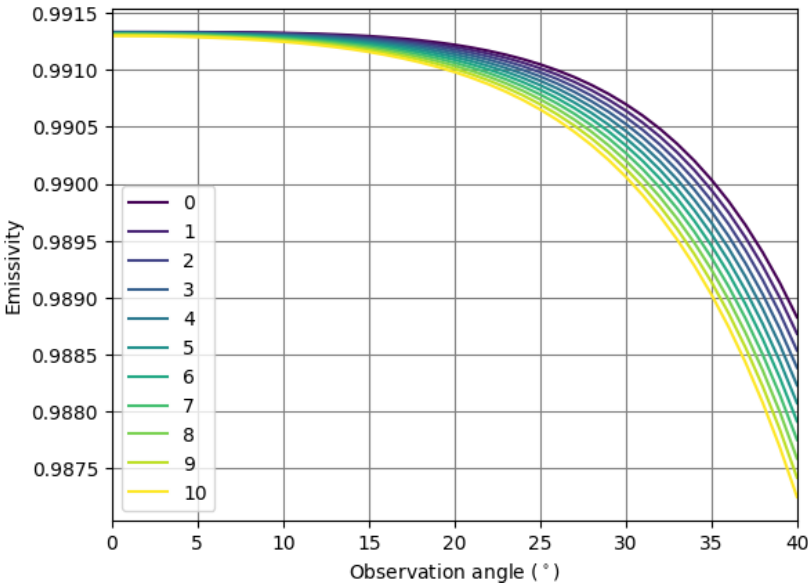
Figure 5. The emissivity of sea water depending on the observation angle calculated according to Masuda et al., 1998 for different wind speeds at 20 ◦ C water